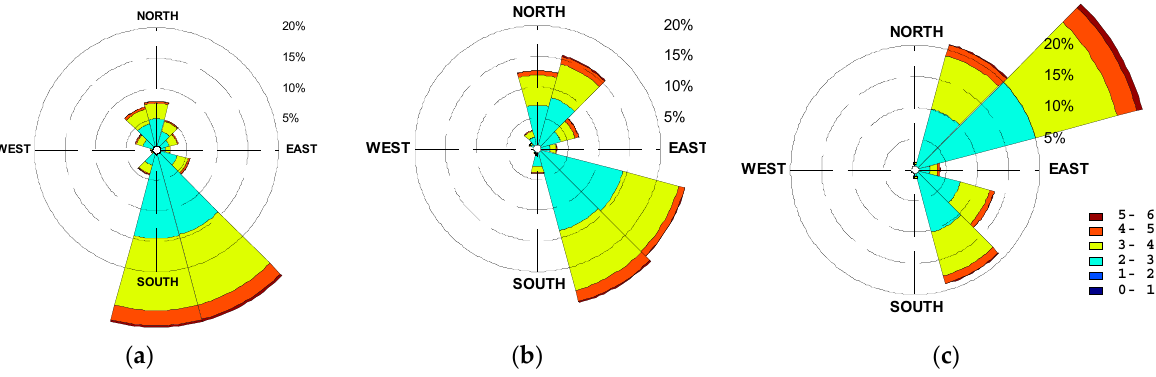
Figure A2. Wave roses with Hs > 2.5 m: ( a ) South Adriatic, ( b ) Central Adriatic and ( c ) North Adriatic